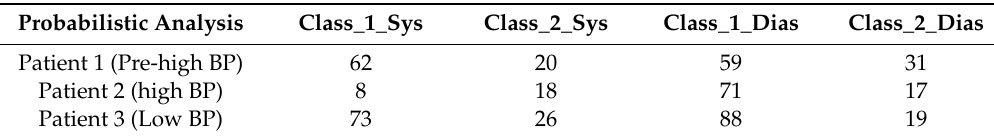
Table 12. Results of anomalies